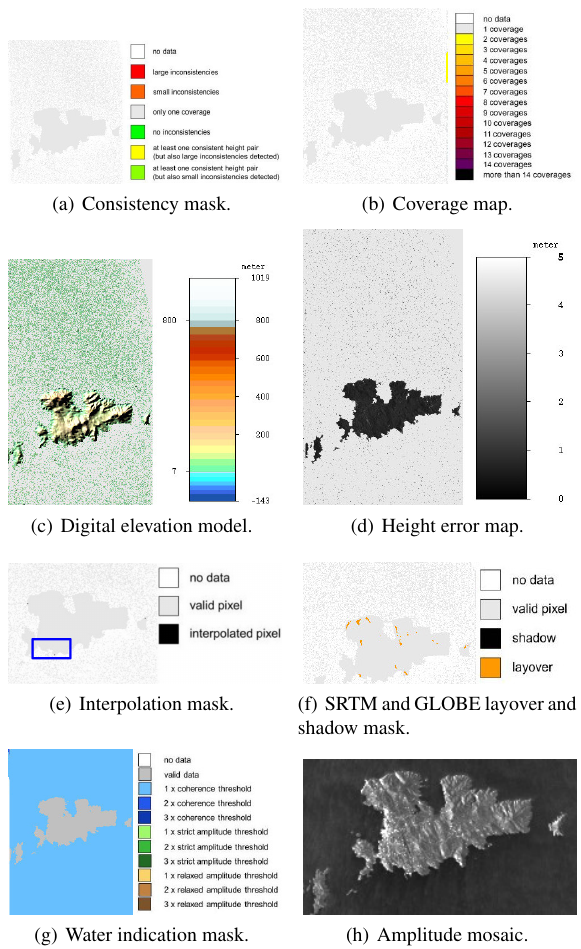
Figure 2. Psarrou study site (marked in blue). The TanDEM-X IDEM data, c (cid:13) DLR